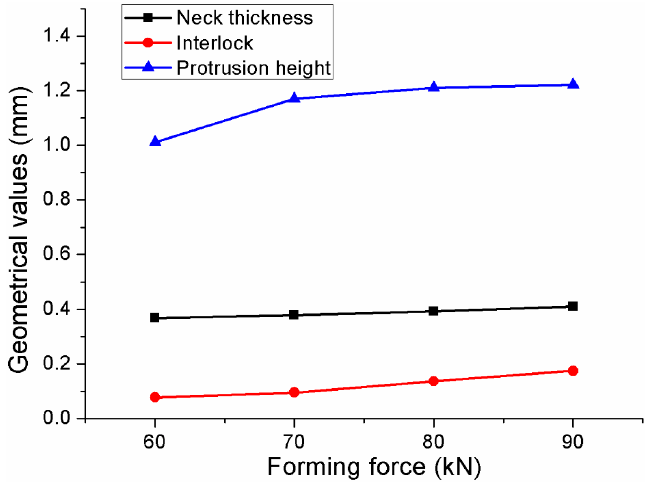
Figure 8. Main geometrical parameters of the improved clinched joints.